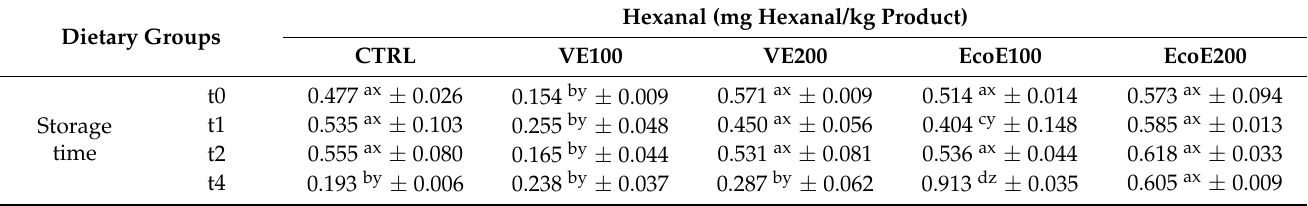
Table 4. The effects of dietary supplementation with α -tocopherol acetate (VE) or EconomasE TM (EcoE) and storage time on the hexanal content (mg/kg product) of packaged rabbit hamburgers.